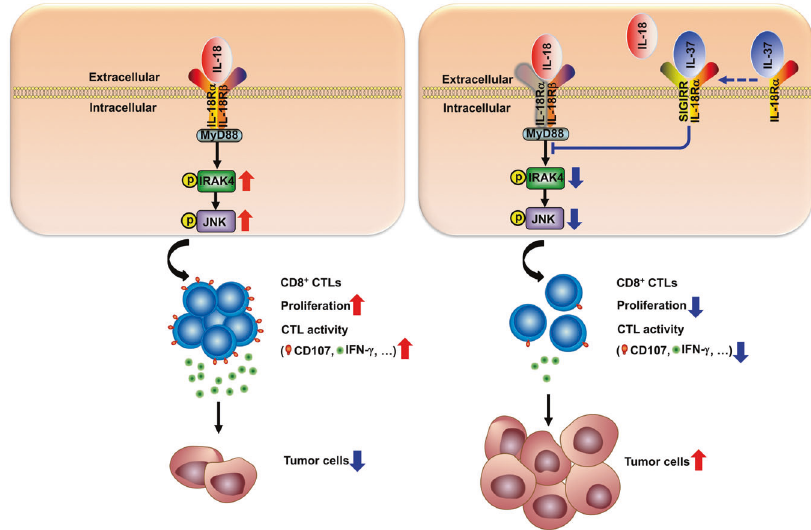
Fig. 9 Schematic representation for the functional mechanism of IL-37 in CRC. IL-37 requires SIGIRR to interrupts the IL-18 drives MyD88 – IRAK4 – JNK signaling in CD8 + CTLs, subsequently leads to suppression of proliferation and cytotoxic activity of CD8 + CTLs, IFN- γ production are decreased. Dysfunctional CD8 + CTLs were deprived of immune surveillance for tumor, enhancing tumorigenesis of colorectal